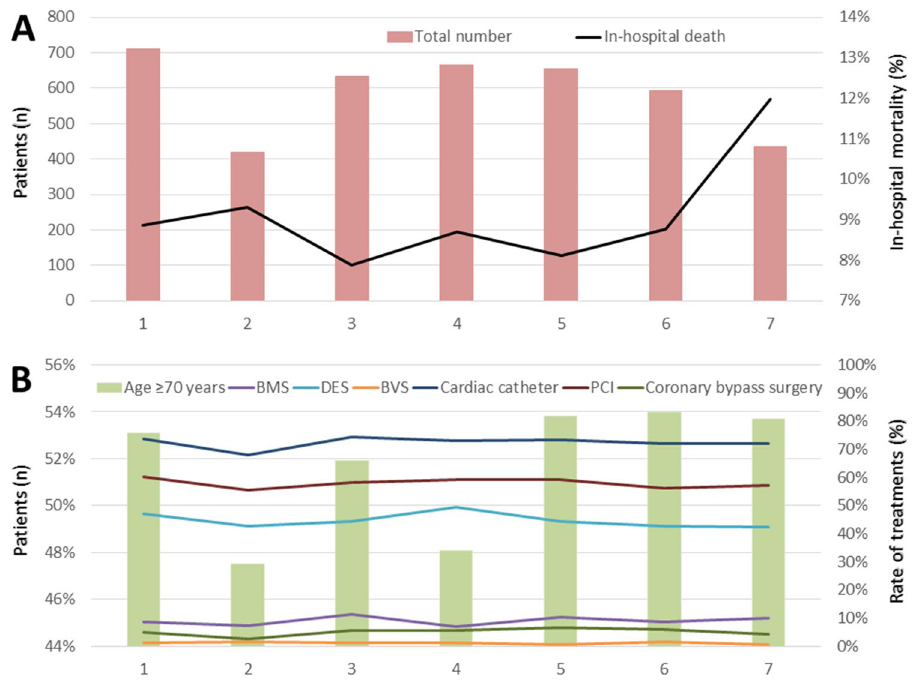
Figure 4. German soccer games during the FIFA world cup 2014. ( A ) Absolute numbers of patients admitted due to MI events (red bars) and in-hospital mortality rate (black line) across the German soccer games during the world cup 2014. ( B ) Proportion of MI events in patients ≥ 70 years (green bars) and different interventional and surgical treatments across the German soccer games during the world cup 2014 (violet line: bare metal stent (BMS) implantation; light blue line: drug eluting stent (DES) implantation; yellow line: bioresorbable vascular scaffolds (BVS) implantation; dark blue line: cardiac catheter; red line: percutaneous coronary intervention (PCI); green line: coronary bypass